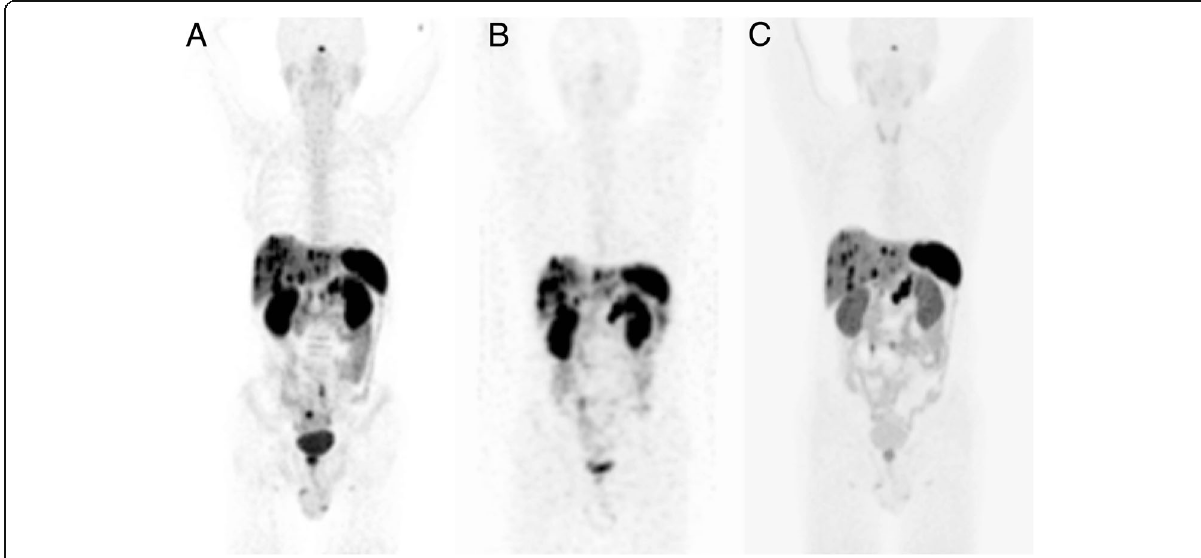
Fig. 3 Theranostics in a patient with a metastatic pancreatic neuroendocrine tumour. a 68 Ga-Dotatate-PET scan for staging. b SPECT evaluation after treatment. c End-of-treatment 68 Ga-Dotatate-PET scan (courtesy of J. Kunikowska, Warsaw)